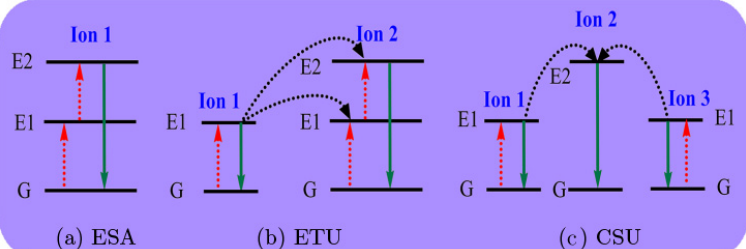
Fig. 1. Principles of UCL process for lanthanide-doped UCNPs. (a) ESA, (b) ETU and (c)